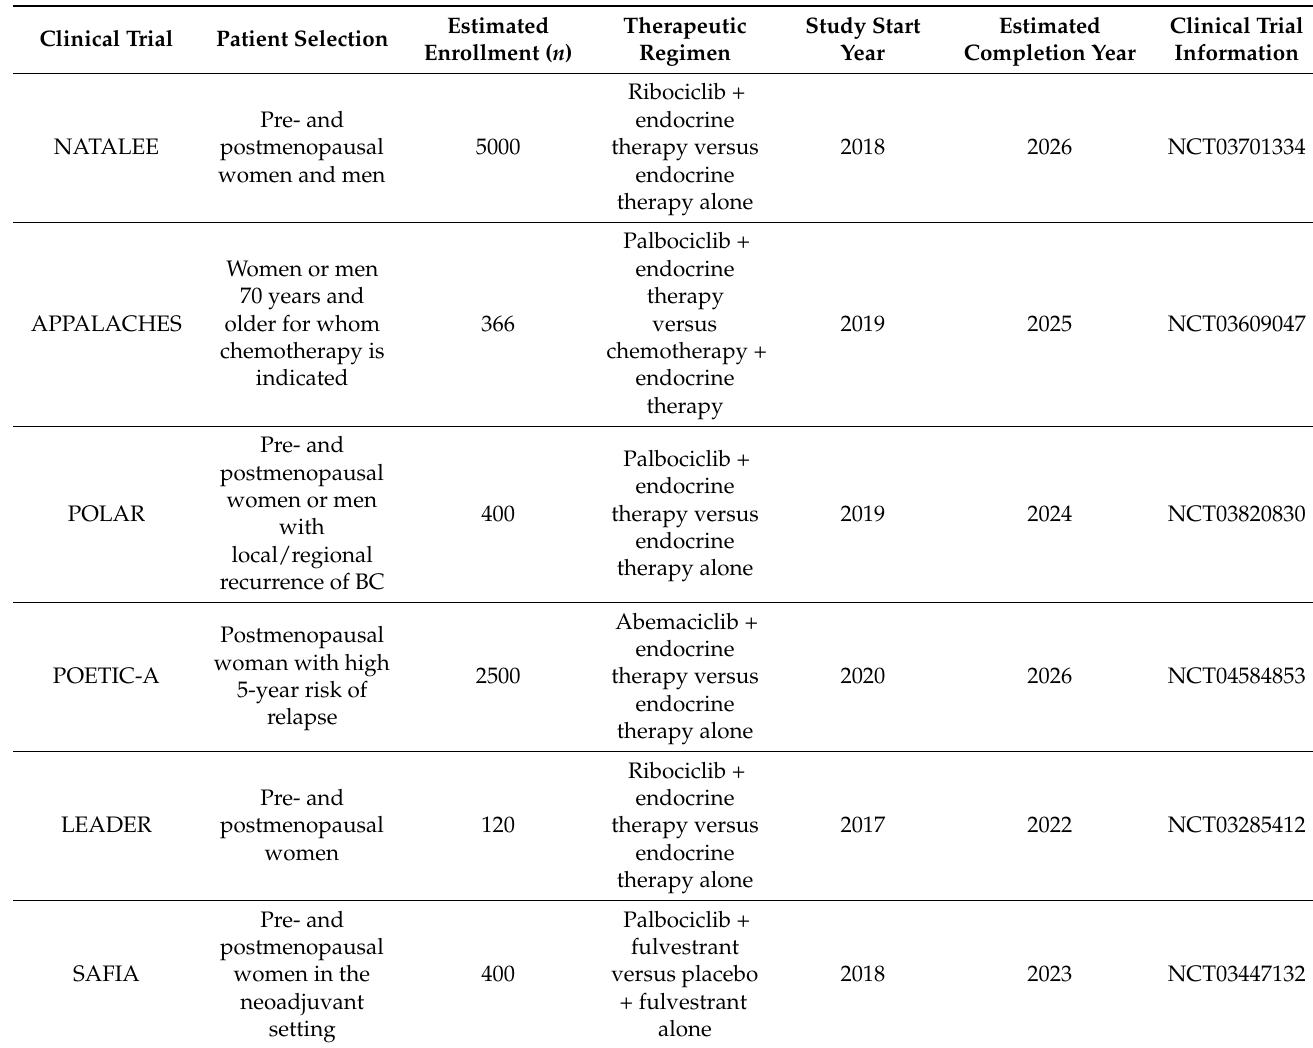
Table 4. Selected ongoing trials with CDK4/6 inhibitors in patients with HR+, HER2 − breast cancer in the adjuvant setting. Clinical Trial Patient